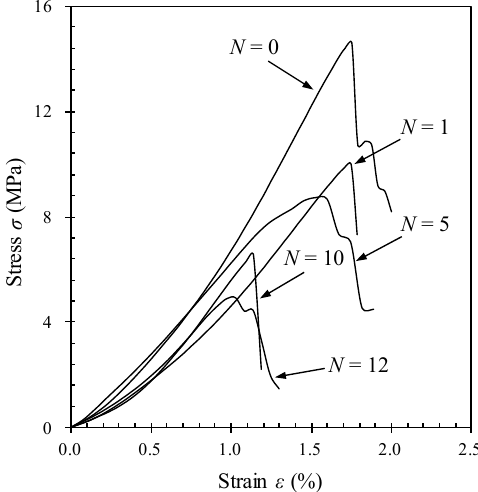
Figure 8. Stress-strain curves of mudstone specimens after wetting-drying cycles.